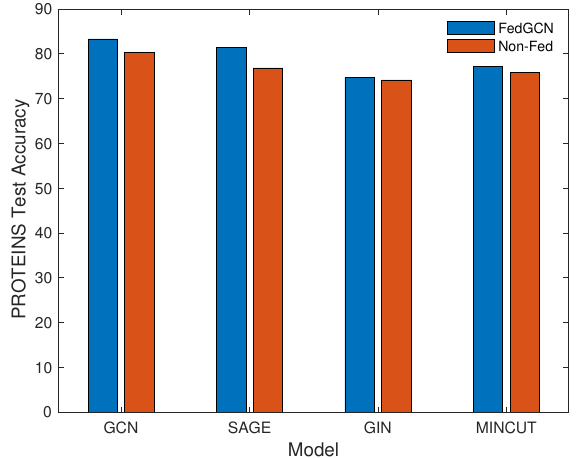
Figure 10. The generality of the FedGCN